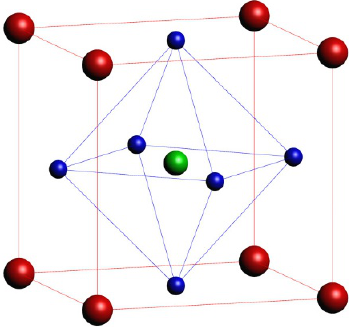
Figure 8 . The perovskite structure ABX 3 . A is red, B is green, and X 3 is